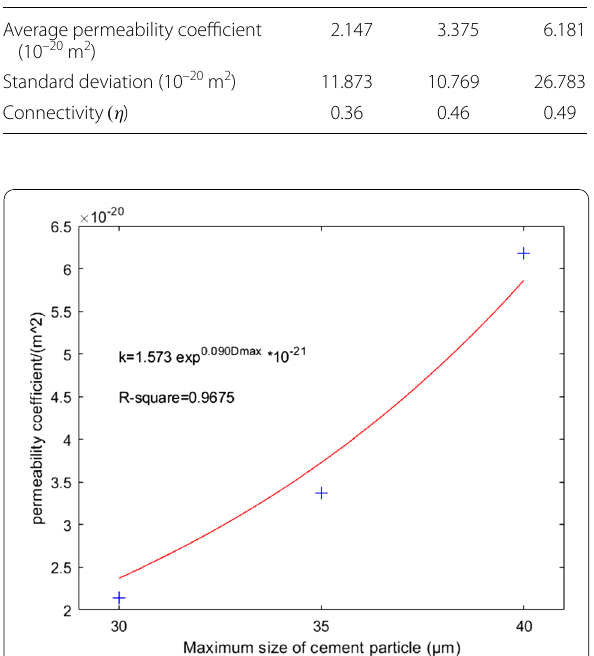
Fig. 14 Fitting curve of upper limit of cement particle size and water permeability